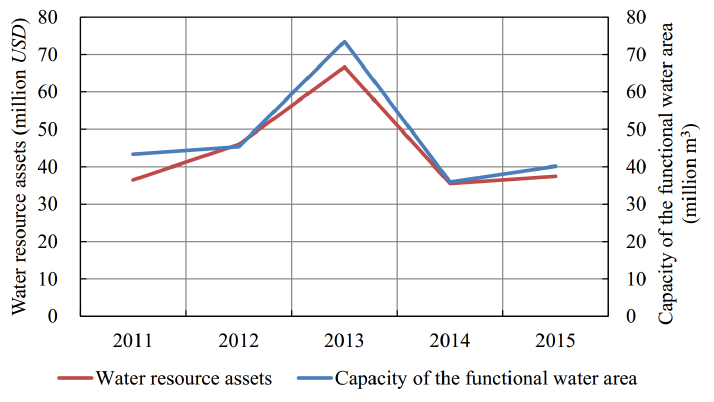
Figure 4. Comparison of the two calculation